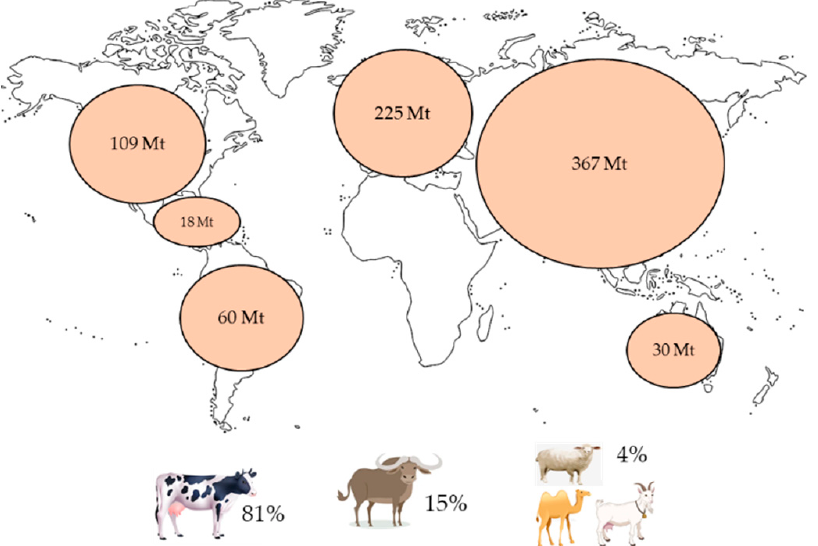
Figure 3. Global milk production and principal types of milk consumed and processed around the world [109]